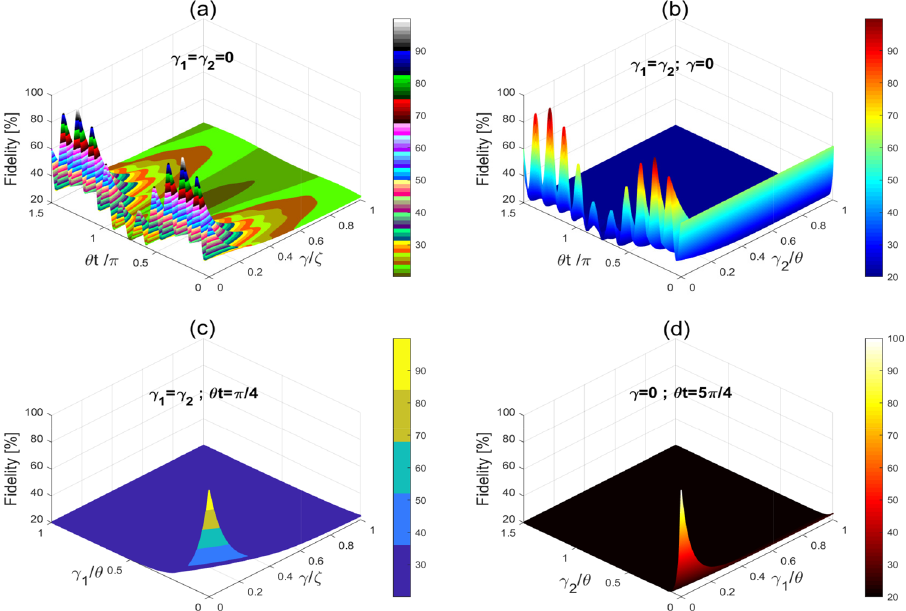
Figure 4. The CN gate fidelity versus the interaction time and dissipation rates. ( a ) Non-interacting atoms versus dissipation and interaction time. ( b ) Interacting atoms versus dissipation and interaction time. ( c ) Interacting and non-interacting atoms versus dissipation at t 5 π versus dissipation at t 4 θ . =